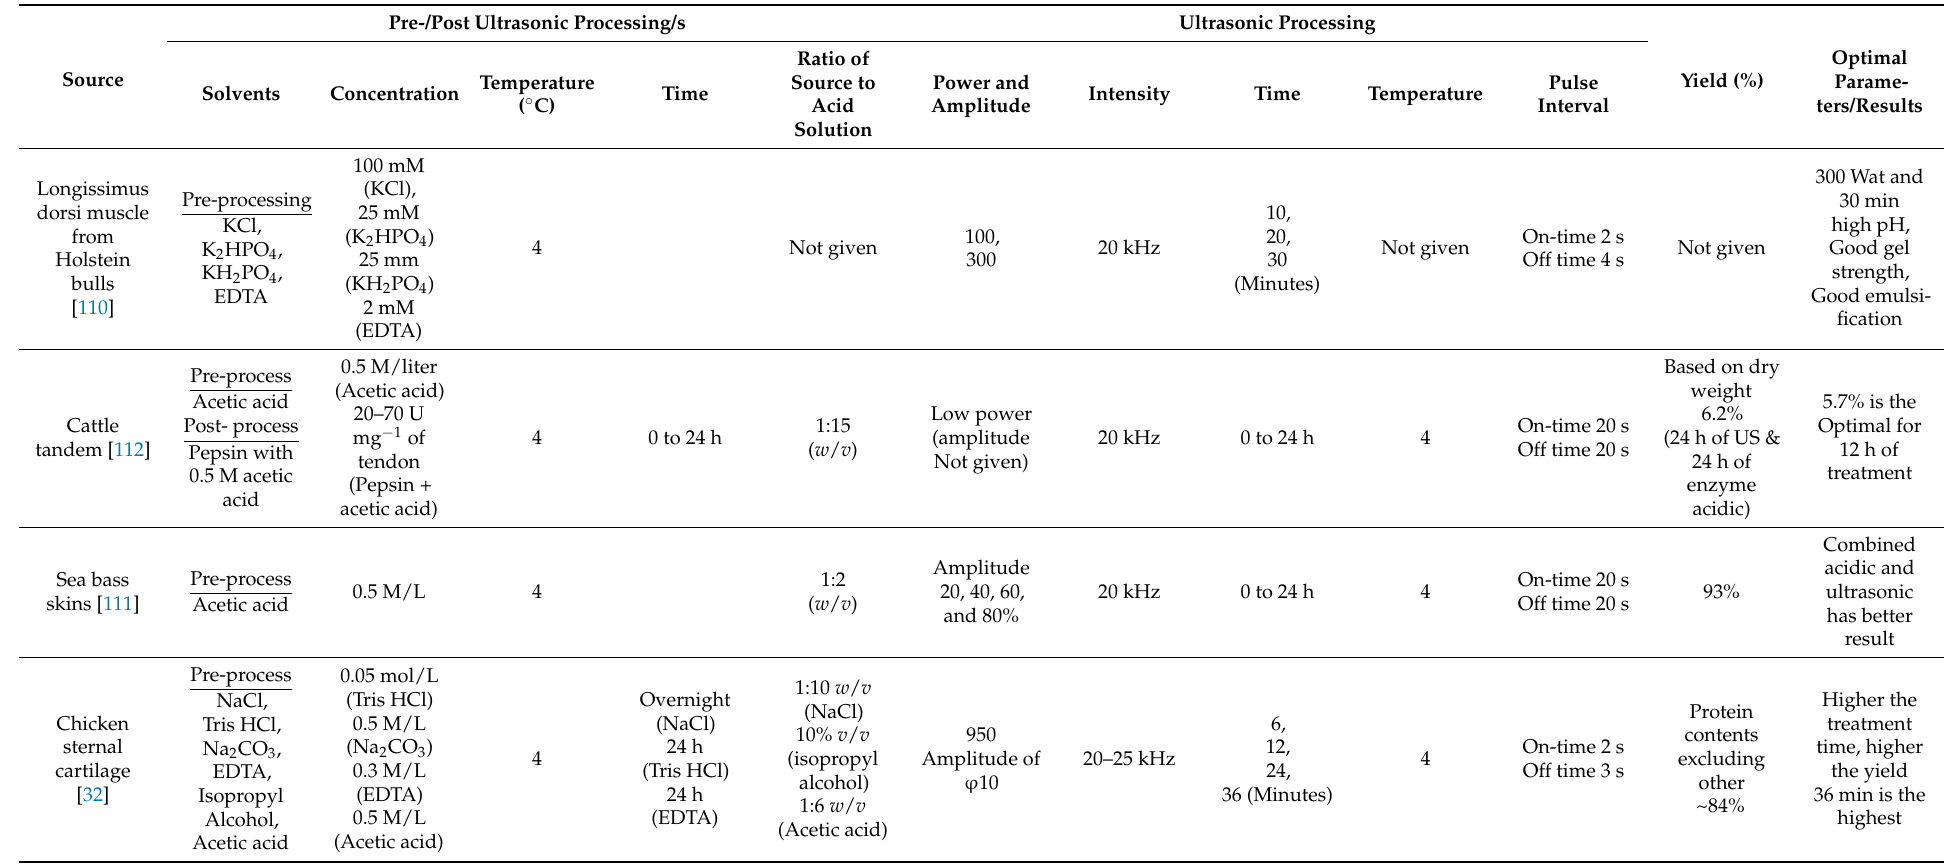
Table 6. Ultrasonic processing for collagen